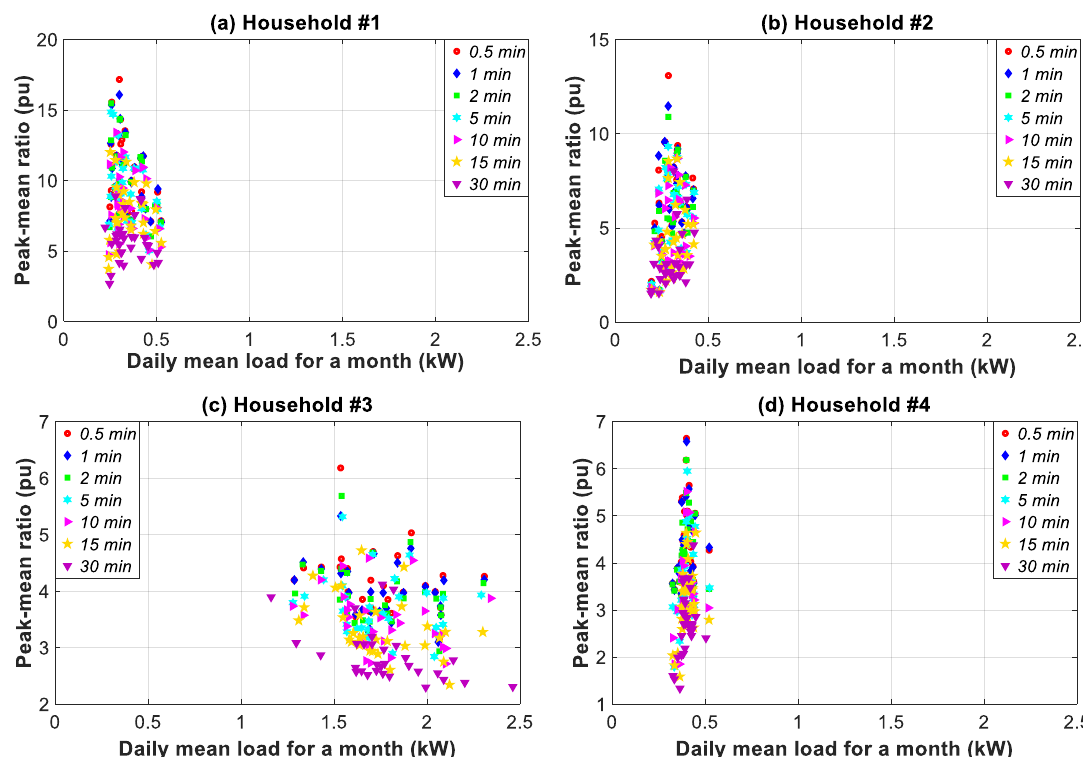
Figure 10. Ratio of daily peak load vs. daily average load in households #1 to #4 for 1.66–30 min data granularity in January.